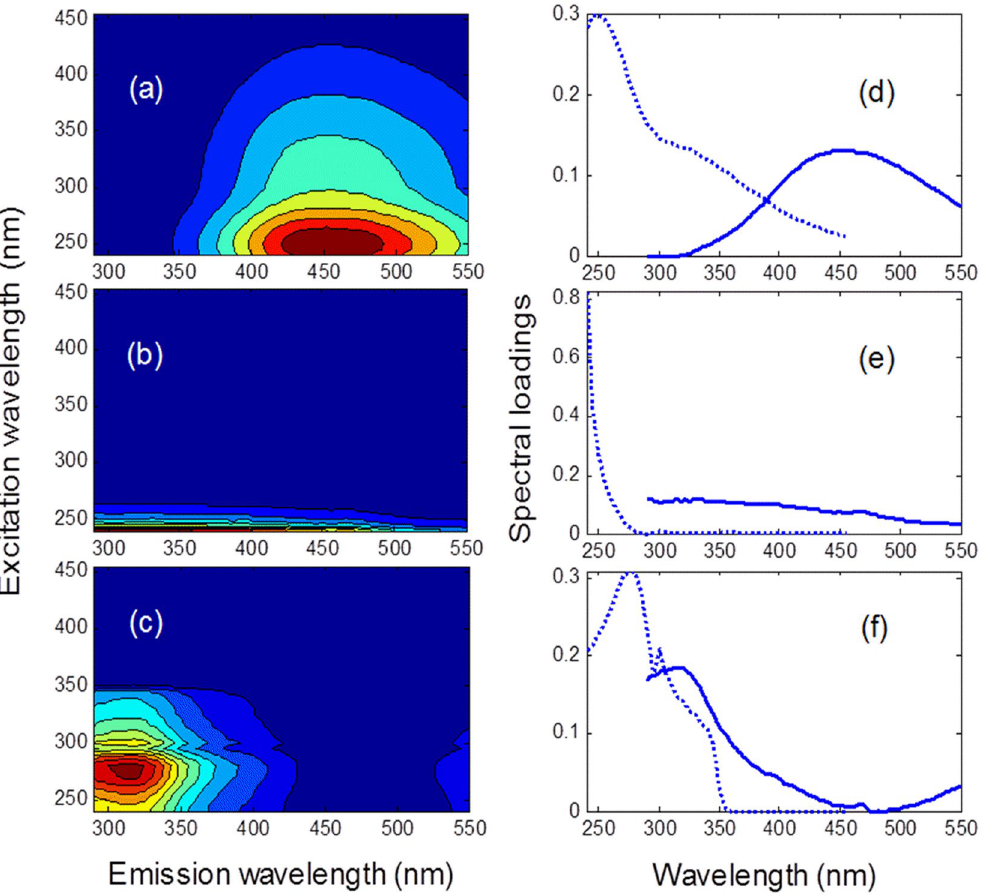
Figure 2. EEMs and spectral loadings of three components modeled by PARAFAC in water extracts of thawing forest soils. ( a ) and ( d ) represent for component 1; ( b ) and ( e ) represent for component 2; ( c ) and ( f ) represent for component 3. The dotted lines show the excitation loadings, and the solid lines represent the emission